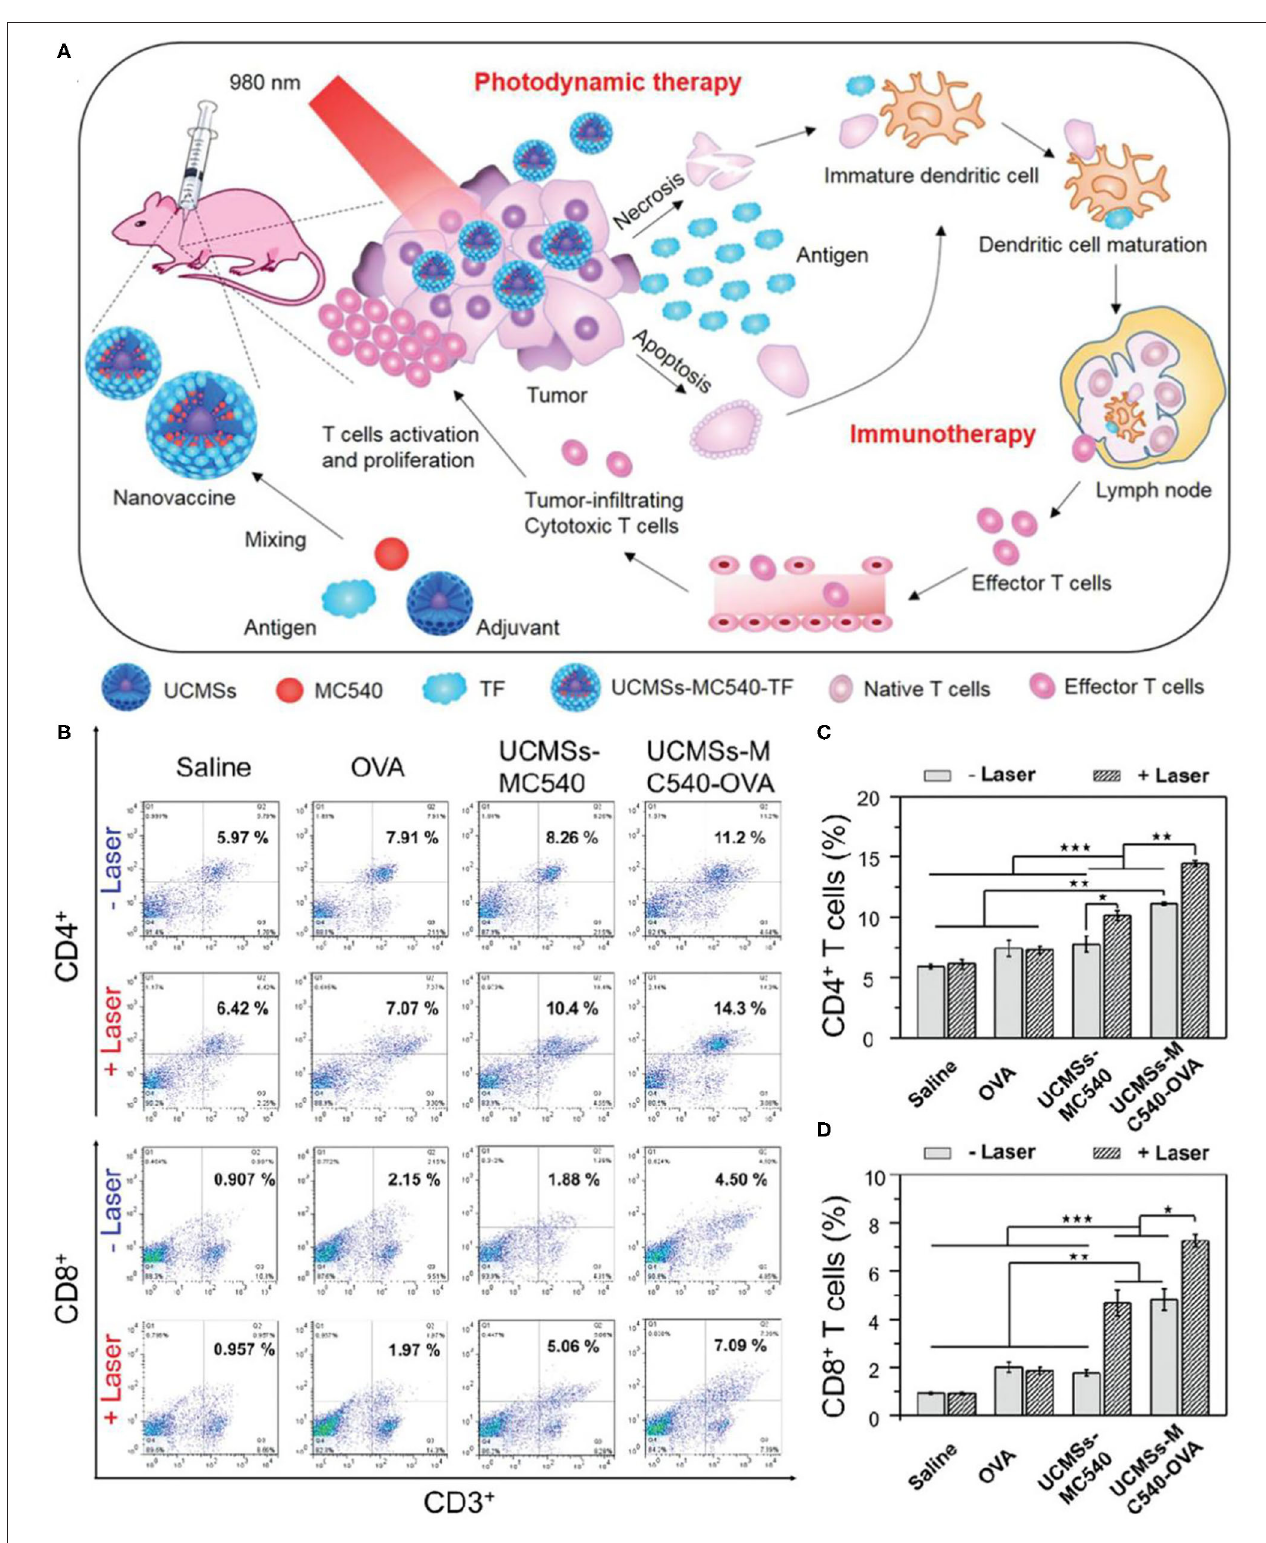
FIGURE 3 | (A) Schematic illustration of fabrication and mechanism of UCMSs-MC540-TF nanovaccines for PDT and immunotherapy. (B) Flow cytometric analyses of the populations of CD4 + (CD3 + CD4 + as the marker) and CD8 + (CD3 + CD8 + as the marker) T cells in splenocytes of mice immunized by various vaccine formulation. (C) The populations of CD4 + after different treatments. (D) The populations of CD8 + after different treatments. Copyright 2018, Wiley-VCH (Ding et al., 2018). * P < 0.5, ** P < 0.01, *** P < 0.001.